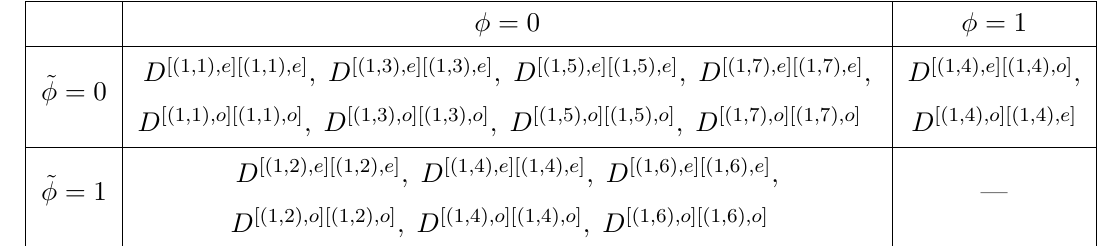
Table 20 . The bi-grading of the generators of the defect and interface classifying algebras of FM (3 ; 8) and g FM (3 ; 8). The parity of a given generator in either of the two defect algebras is called (cid:30) , and in the interface algebra it is called ~ (cid:30) , with the identi(cid:12)cations used in